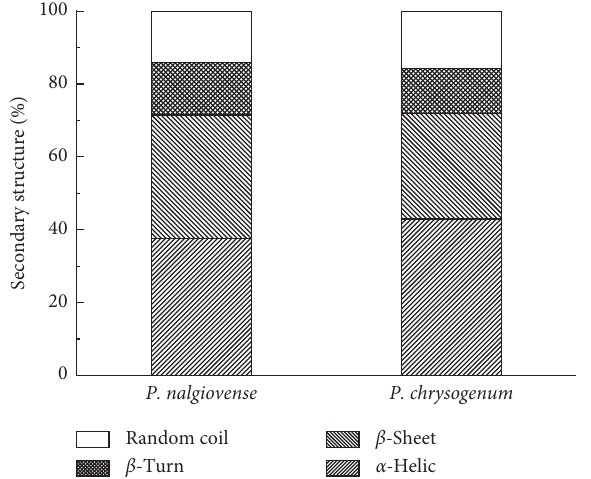
Figure 5: Secondary structure fractions estimated from the amide I band in fermented chicken meat with P. nalgiovense and P. chrysogenum . Table 1: Normalized intensities of tryptophan and tyrosine residue microenvironment in fermented chicken meat products. Treatment Trp band ( I 760 / I 1003 cm − 1 )